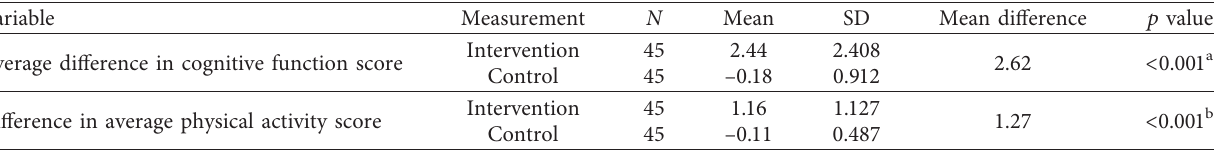
Table 6: Differences in the mean difference of cognitive function scores and physical activity pretest and posttest in the intervention group and control group in Dago Village Community Health Center working